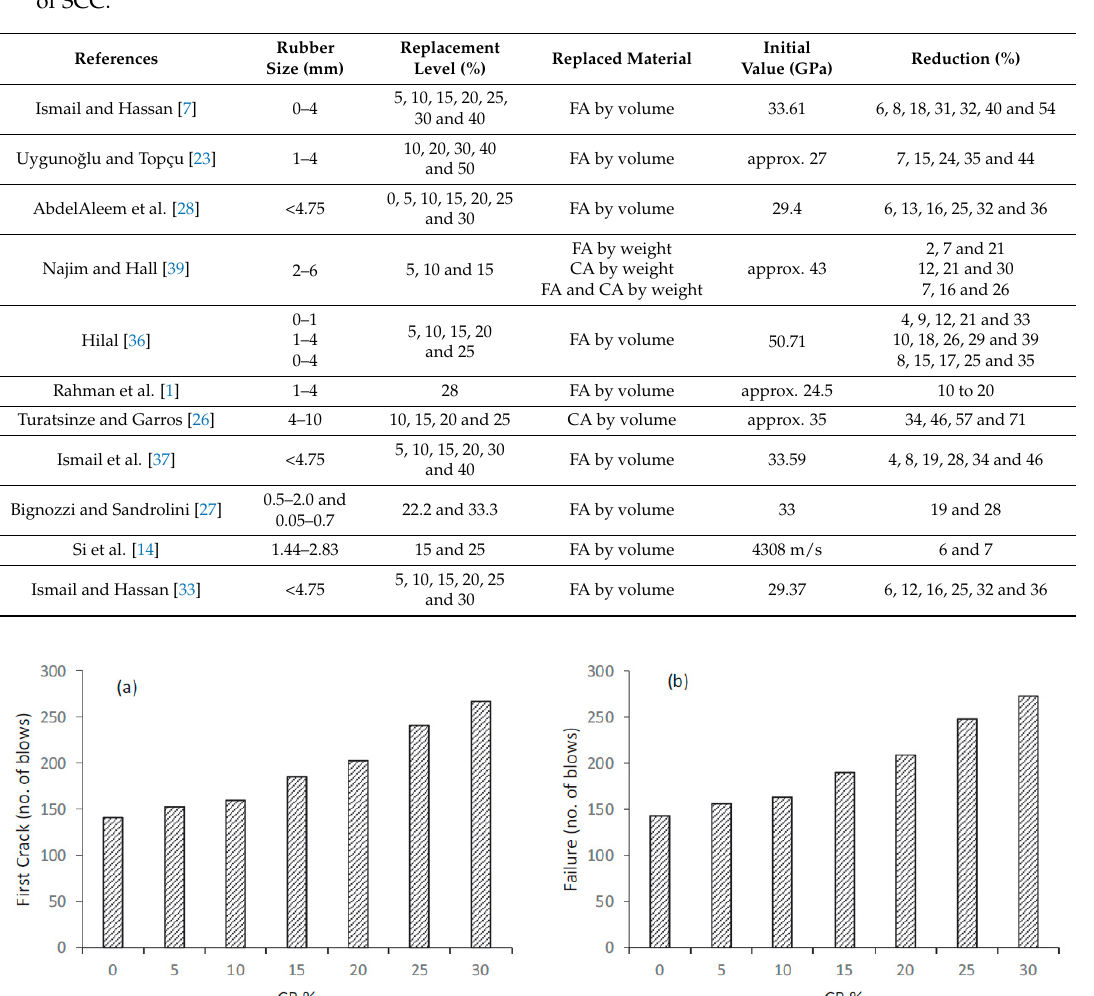
Table 6. Influence of rubber size, replacement level and replaced material on modulus of elasticity of SCC.